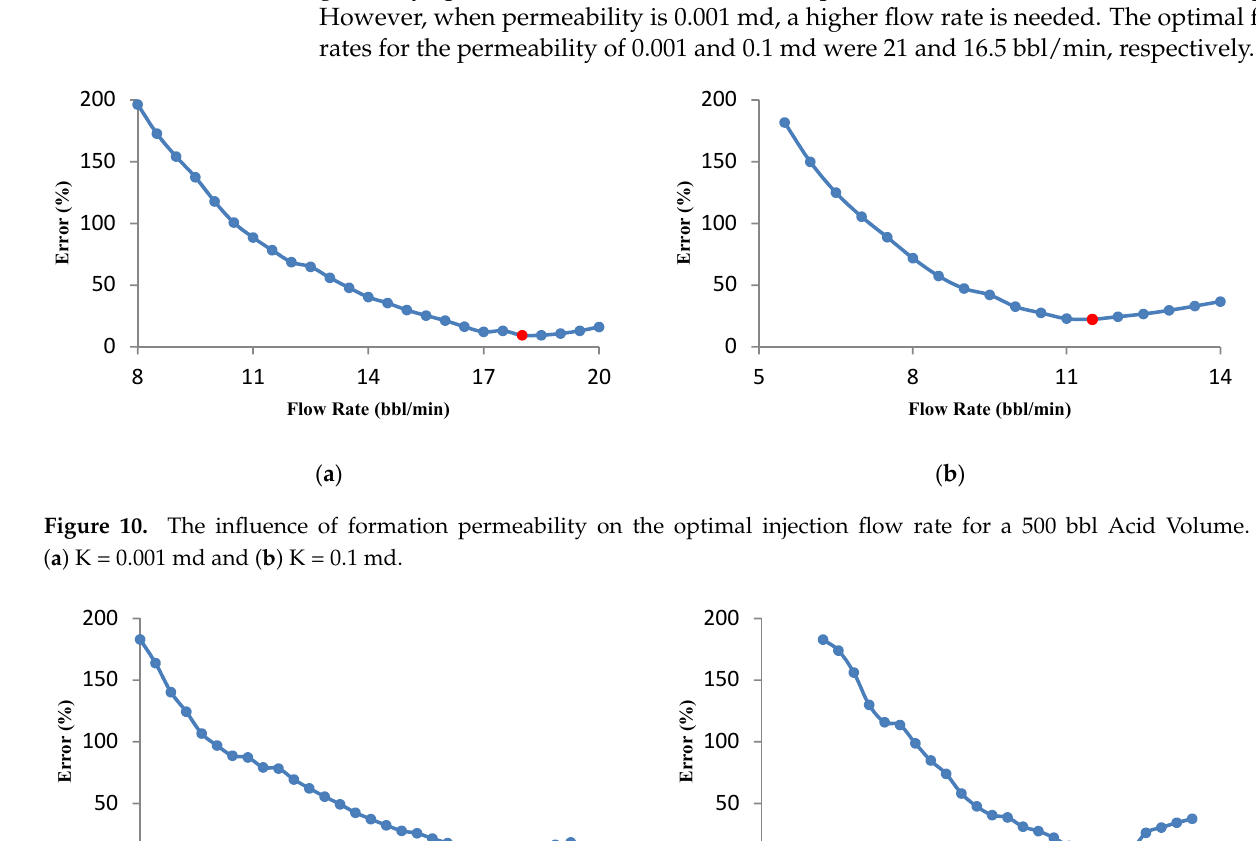
Table 3. Property of three acid systems types studied [37].